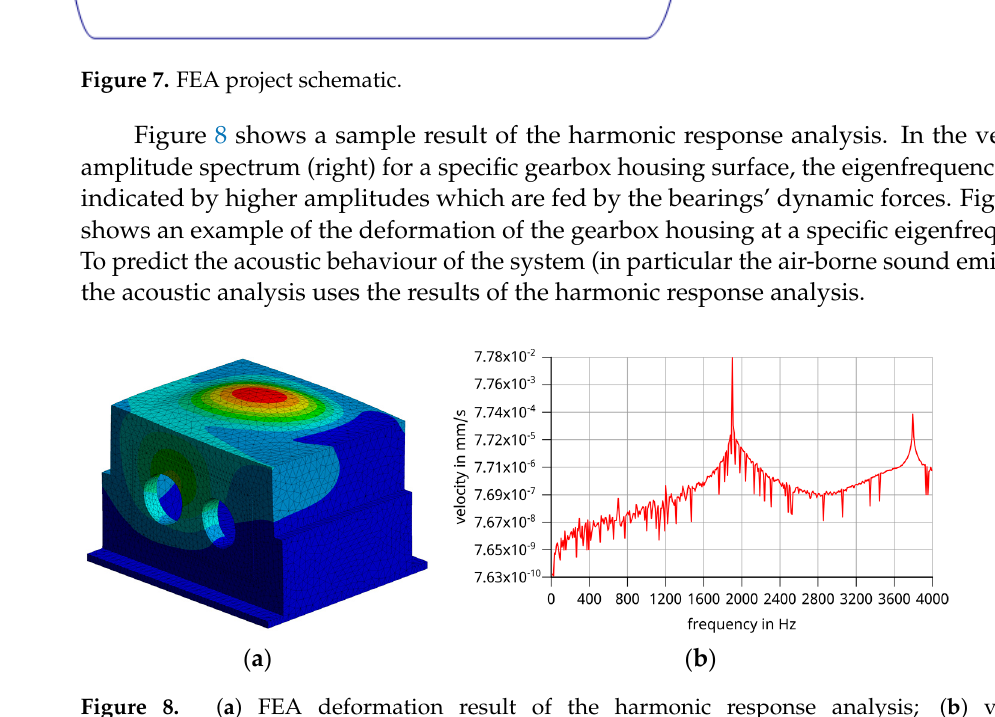
Figure 8. ( a ) FEA deformation result of the harmonic response analysis; ( b ) velocity amplitude spectrum.